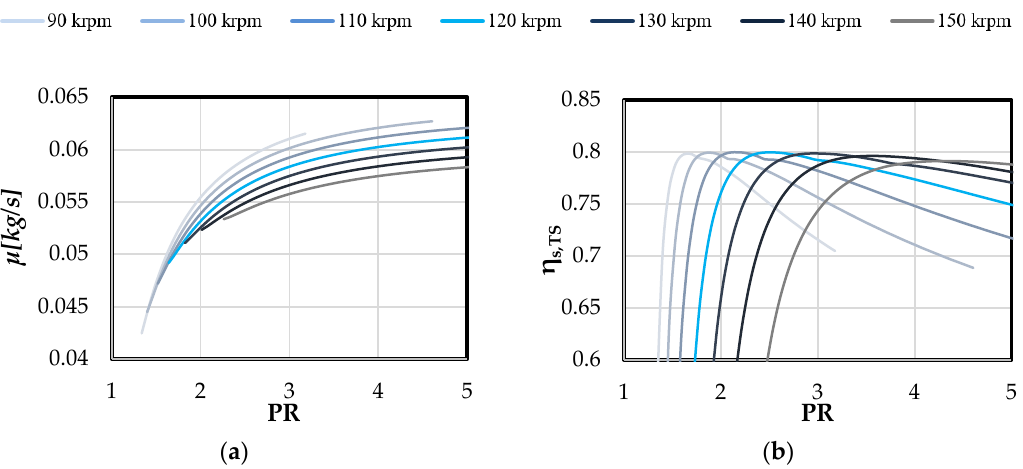
Figure A4. Turbine maps obtained for different rotational speeds. ( a ): corrected mass flow rate vs pressure ratio. ( b ): Total to static isentropic efficiency vs pressure ratio.